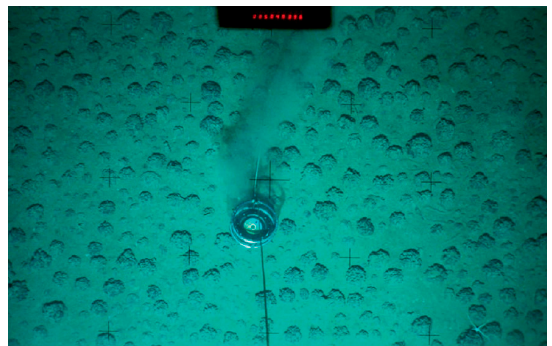
Figure 1. High abundance of large nodules on the seafloor of the Peru Basin (ca. 4000 m water depth) [28].